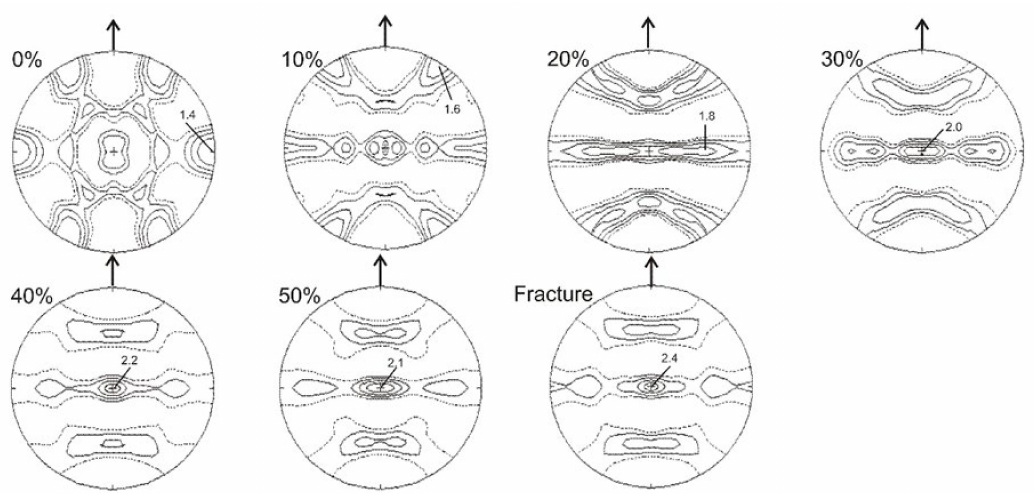
Figure 6. Calculated pole figures for austenite {110} in the initial state (0%) and after selected deformation degrees.